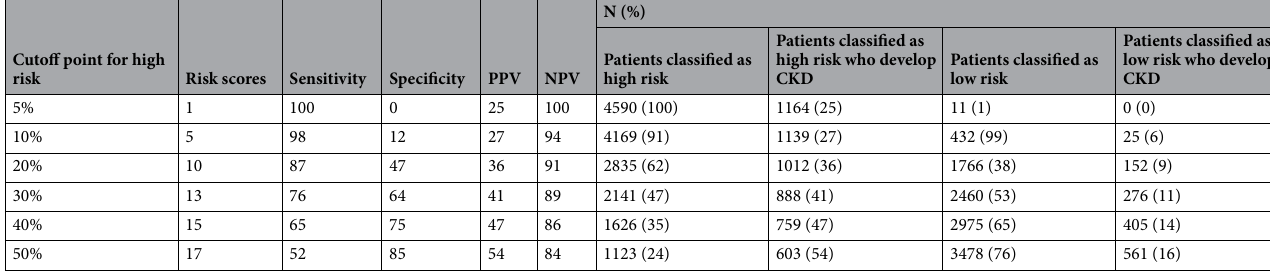
Table 4. Risk classification of sensitivity, specificity, PPV, and NPV. PPV Positive predictive value, NPV Negative predictive value, CKD chronic kidney